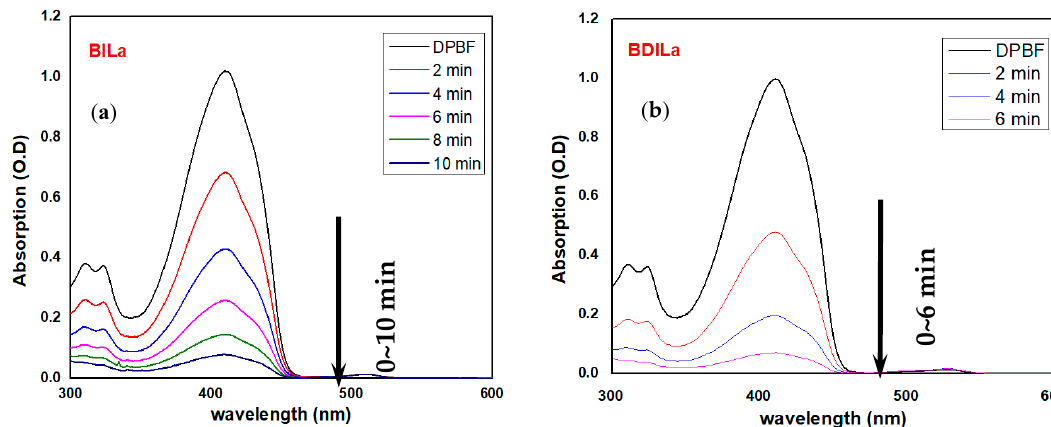
Figure 4. Time-dependent absorption spectra of 1,3-diphenylisobenzofuran (DPBF) in EtOH with ( a ) BILa and ( b ) BDILa after LED light excitation at 500 nm.